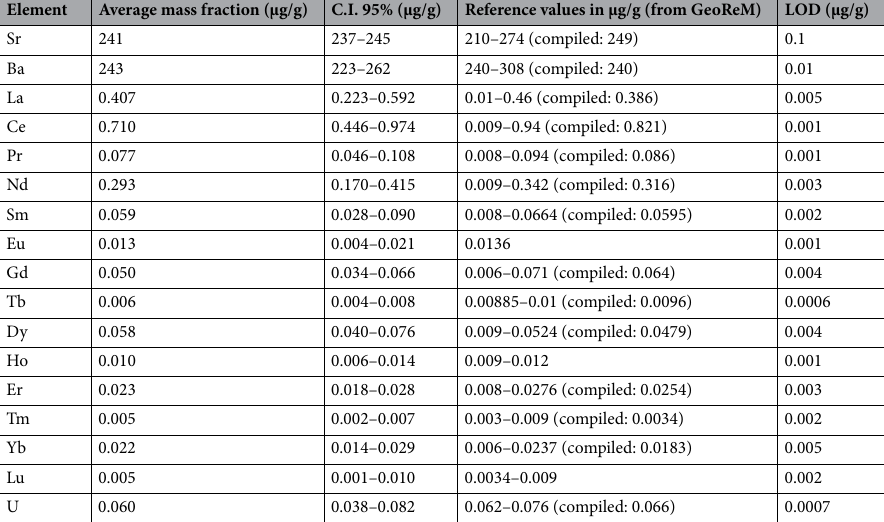
Table 3. Compositional data of the quality control reference material (NIST SRM 1400, bone ash). Average and confidence interval (C.I.) are calculated based on 9 spot analyses (i.e., replicas). Limit of detections (LOD) are reported as 3σ of the